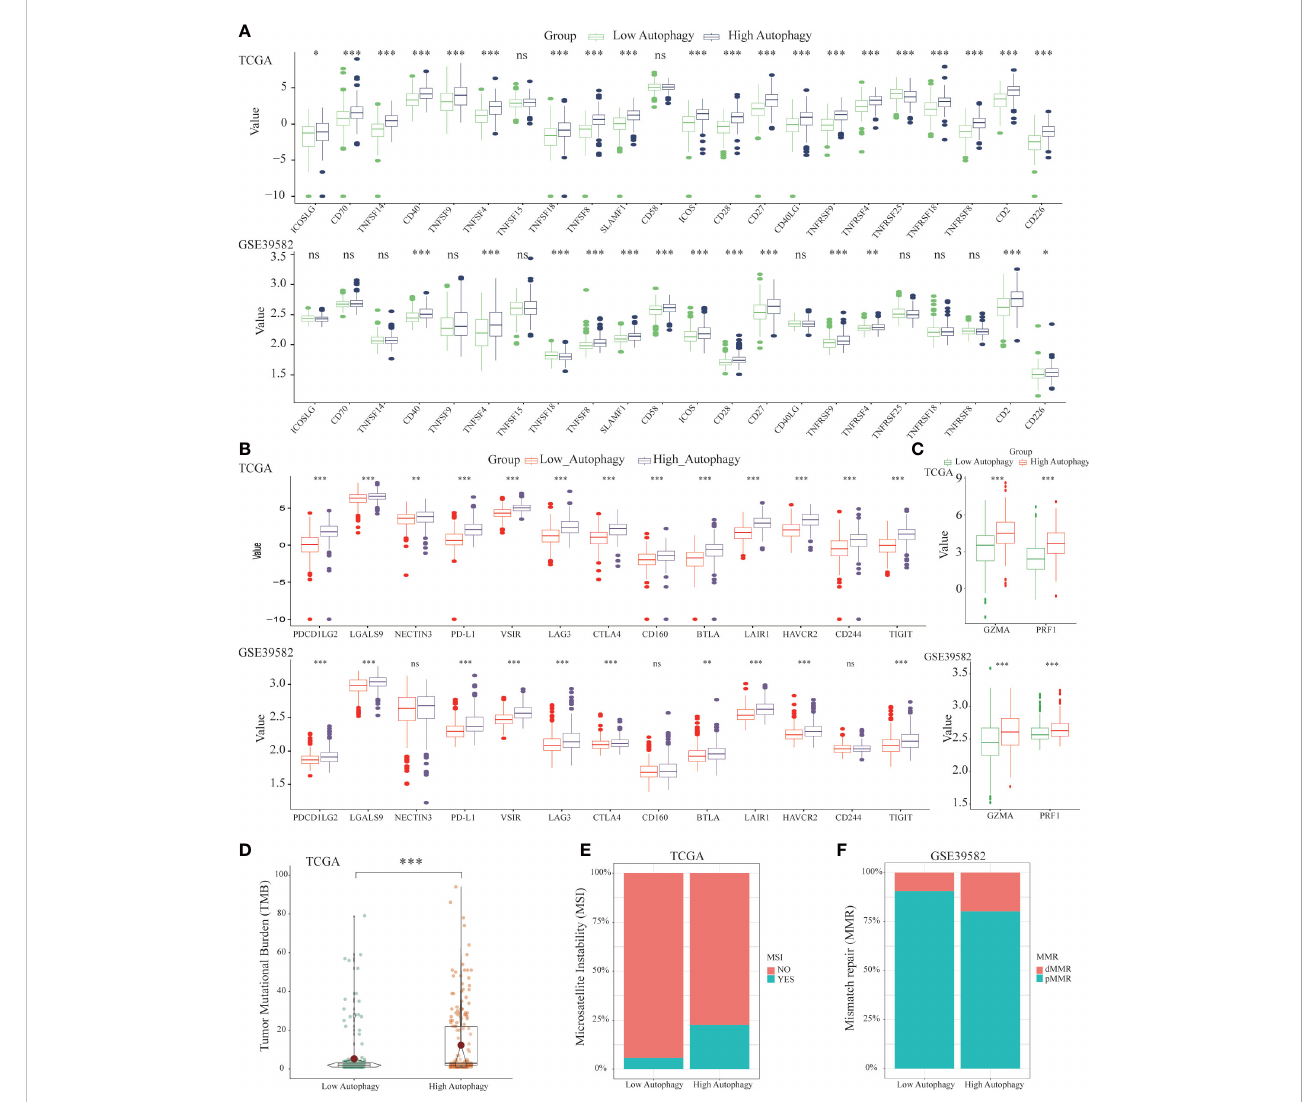
FIGURE 3 Differences of co-signaling molecules (co-stimulatory molecules, co-inhibitory molecules), cytolytic activity genes, tumor mutational burden (TMB), microsatellite instability (MSI) and mismatch repair (MMR). Comparison of the APC and T cell co- stimulatory molecules (A) , co-inhibitory molecules (B) , cytolytic related genes (C) , tumor mutational burden (TMB) (D) between low and high autophagy group. The high autophagy group had a higher proportion of MSI (E) and dMMR (F) . (* P -value < 0.05; ** P -value <0.01; *** P -value